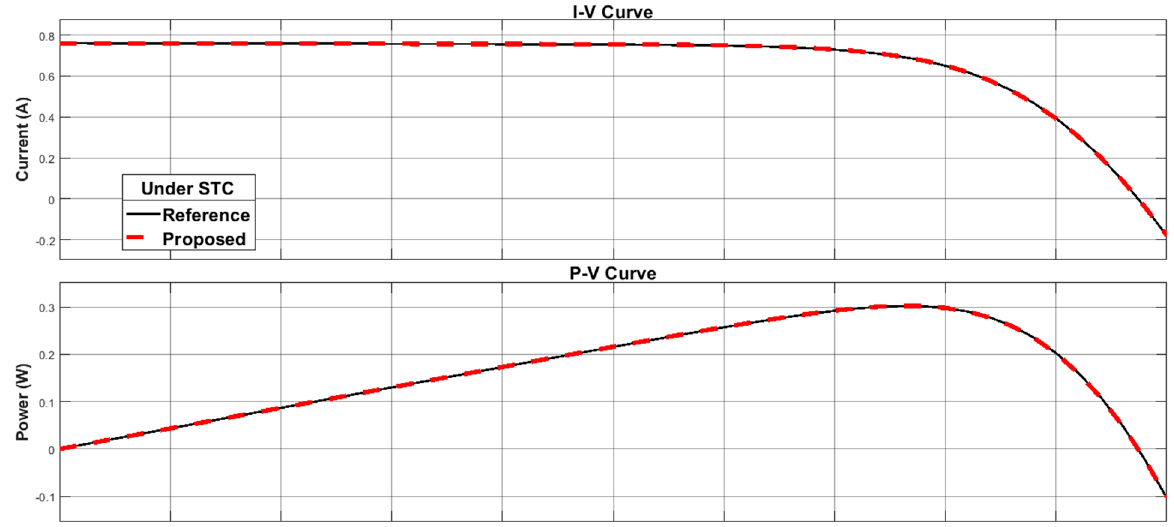
Figure 9. Boxplot of the error in current for the proposed model and other models from the literature (WHHO [14], ABC [36], and BMO [38]) compared to the original data regarding the R.T.C. France model.